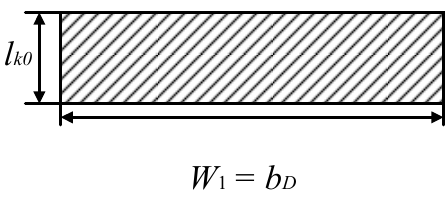
Figure 8. Area of contact area without included angle.